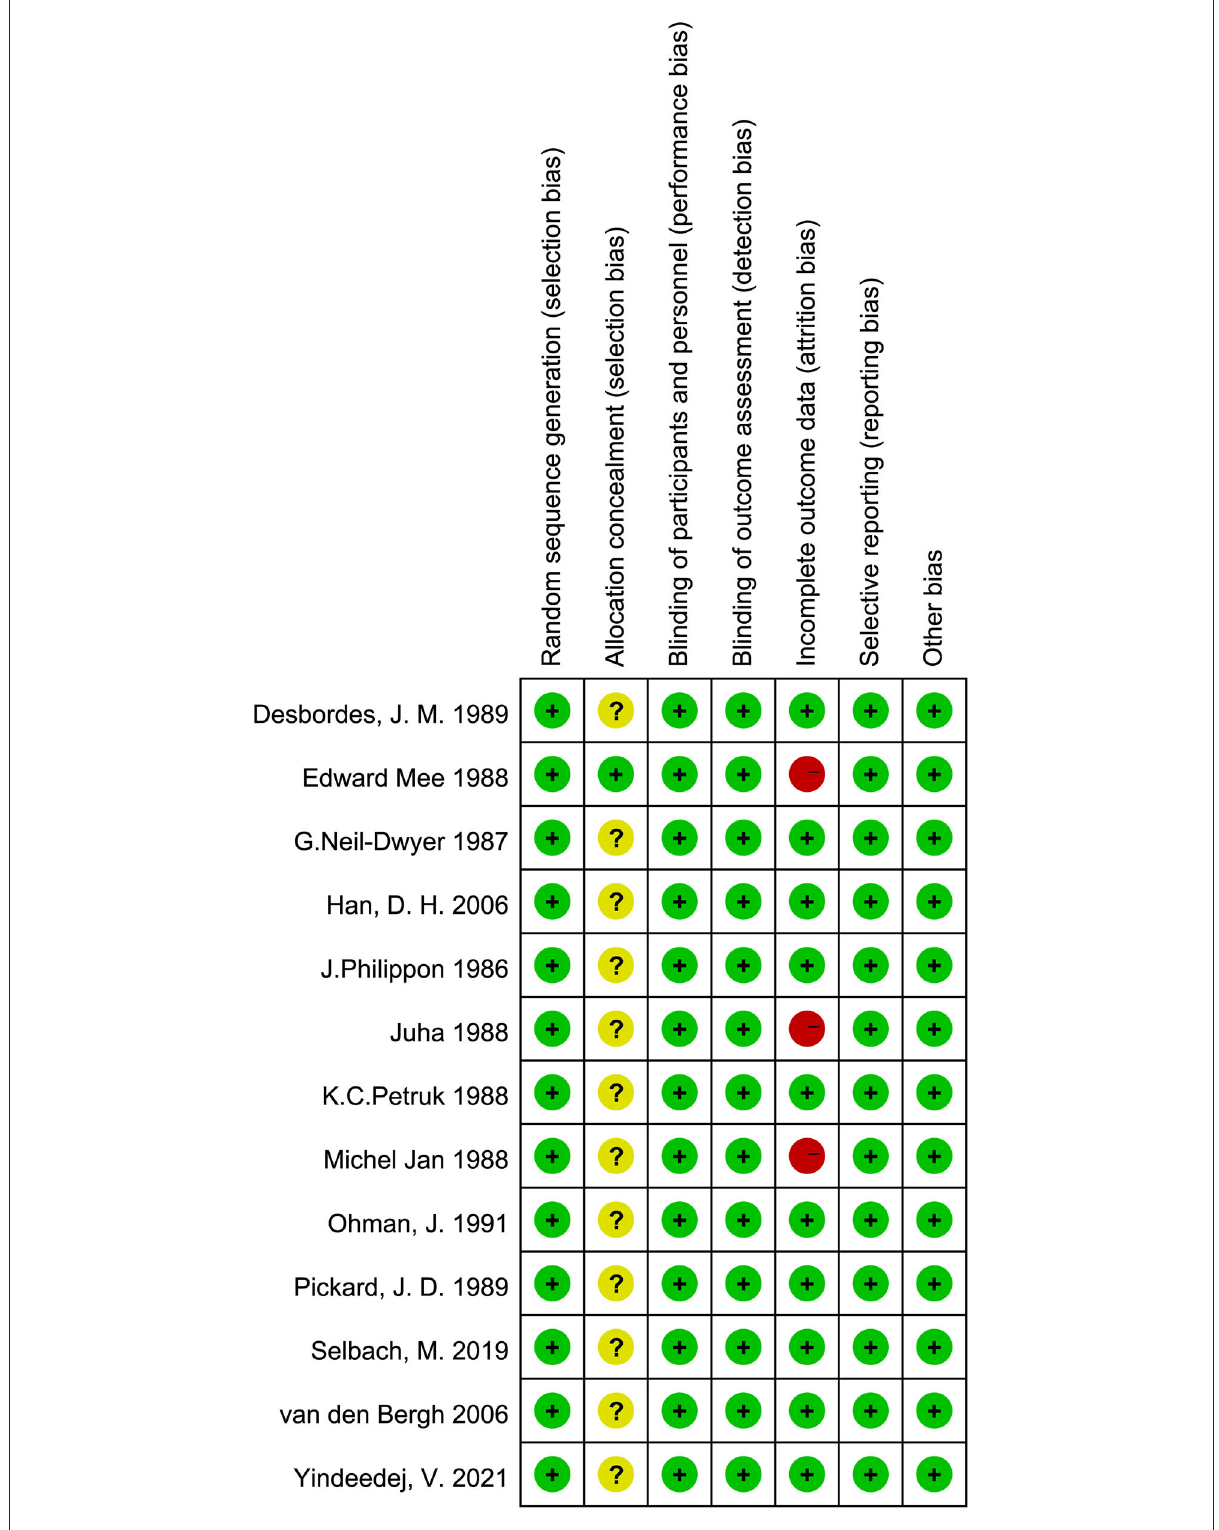
FIGURE2 Quality of the included RCTs assessed by Cochrane Risk of bias